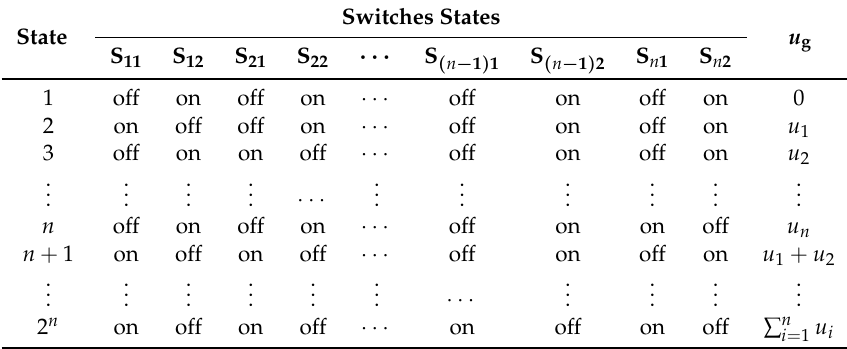
Table 1. Values of u g under different switch states of the first